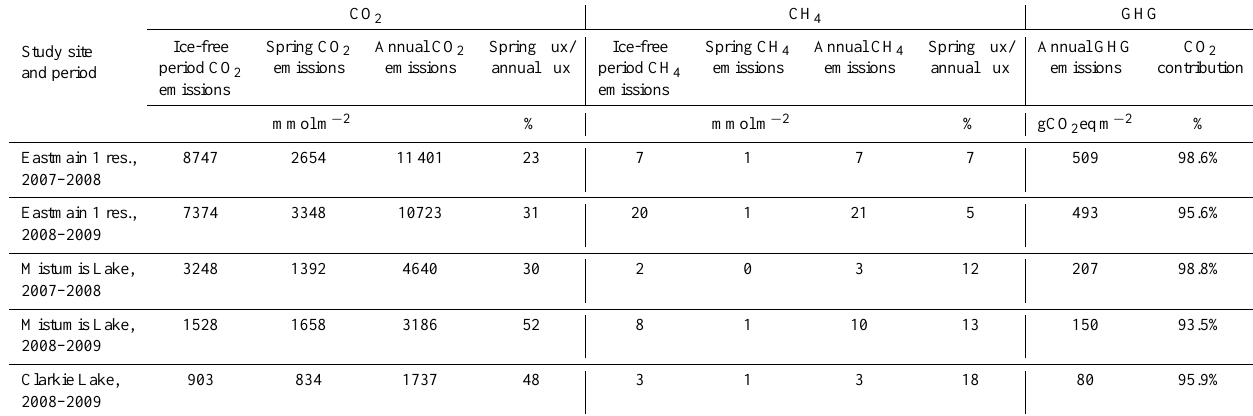
Table 6. Ice-free period, spring and annual CO 2 , CH 4 and GHG emissions for water bodies studied. Note that emissions from reservoirs are gross